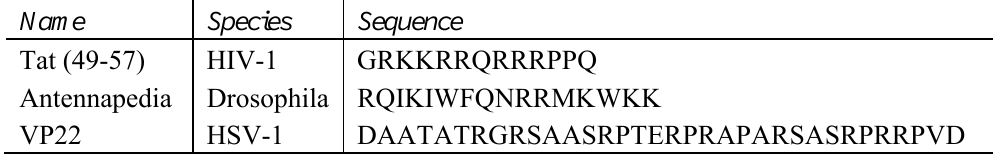
Table 1. Amino acid sequence of protein transduction